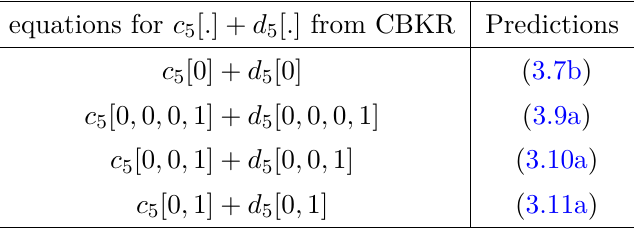
Table 1 . Predictions for the sums d 5 [ . ] + c 5 [ . ] following from CBK relation.